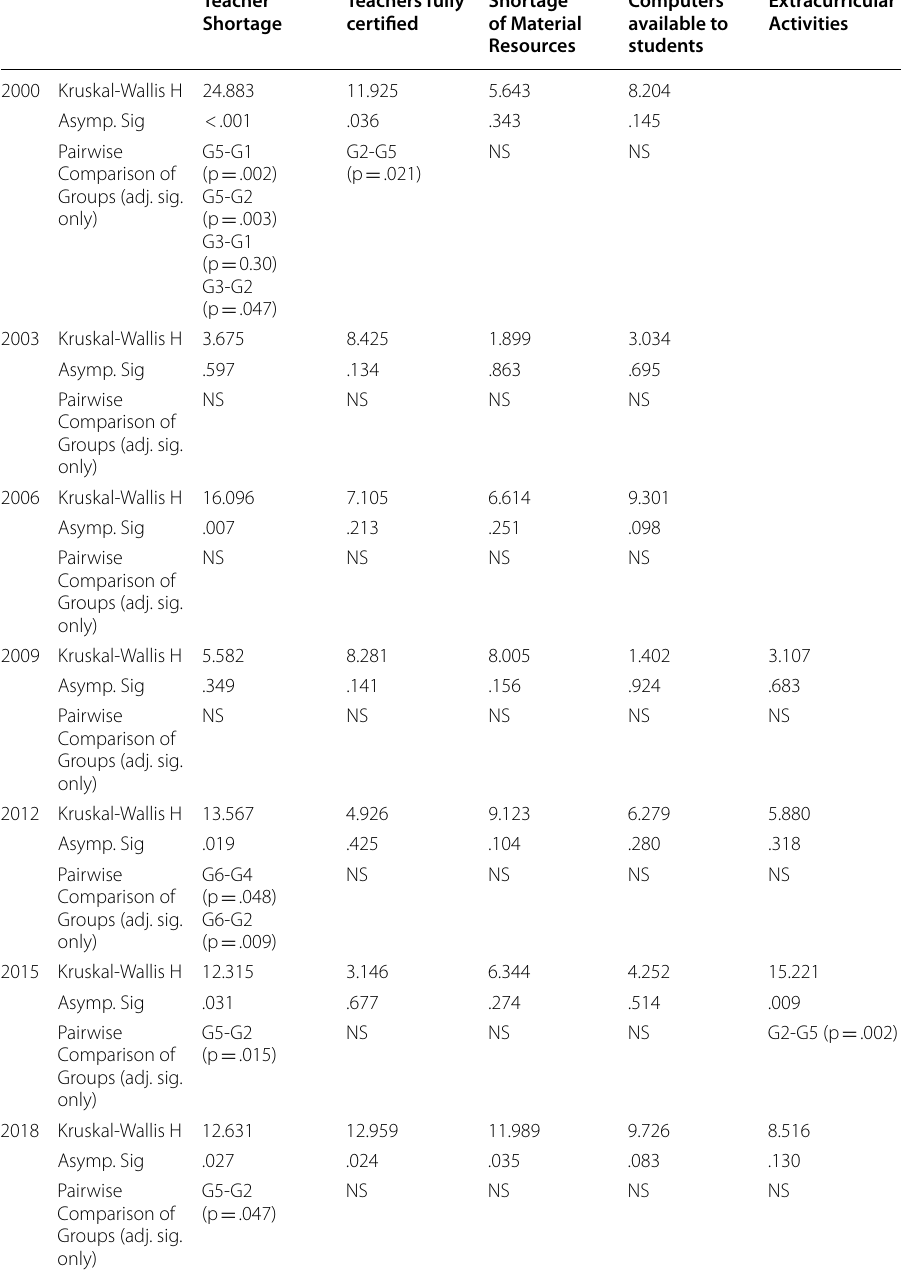
Table 6 Kruskal–Wallis H test and pairwise comparison of 6 school groups across all PISA